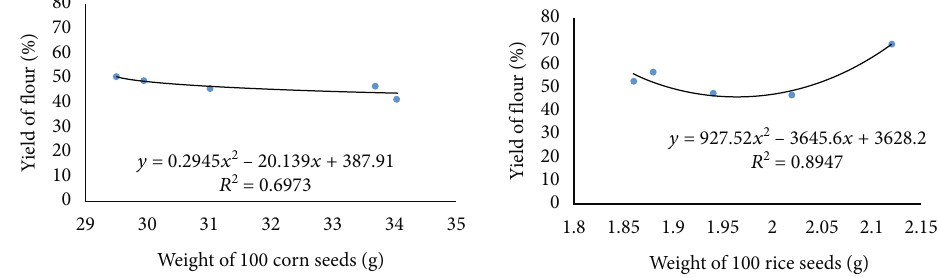
Figure 4: The relationship between fl our yield and weight of 100 seeds.